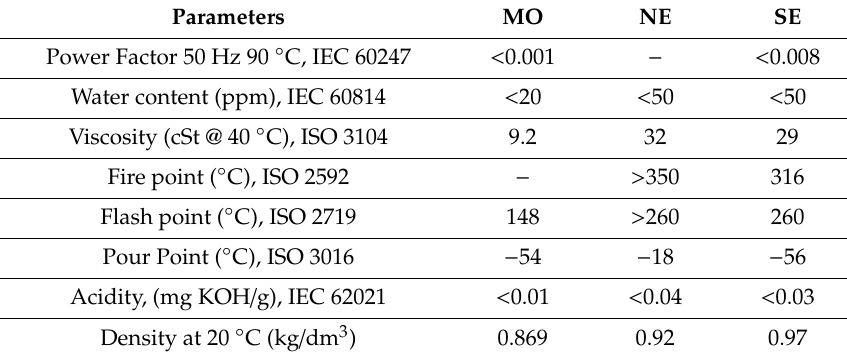
Table 1. Significant properties of the unused base oils used in this